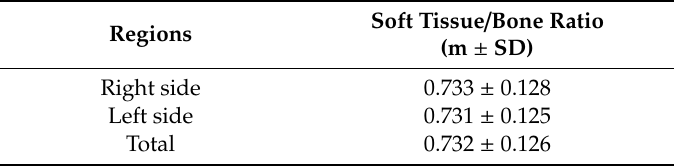
Table 4. Ratio of 3D soft tissue to bone sagittal